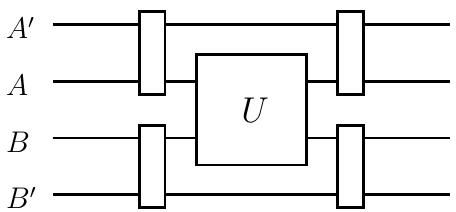
Figure 1 . The most general protocol that A and B can perform that uses U exactly once and that makes use of their freely-available resources: local unitary operations, ancillae ( A 0 and B 0 ), and classical communication. (The classical side channel is not explicitly